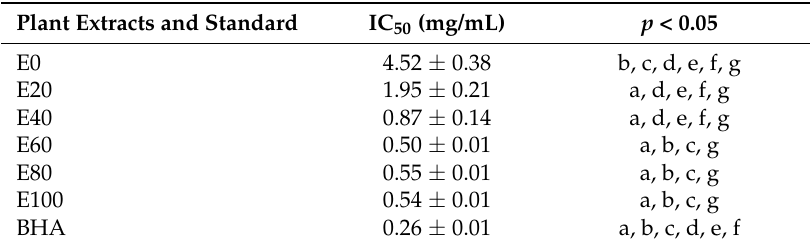
Table 6. IC 50 values of extracts and standard